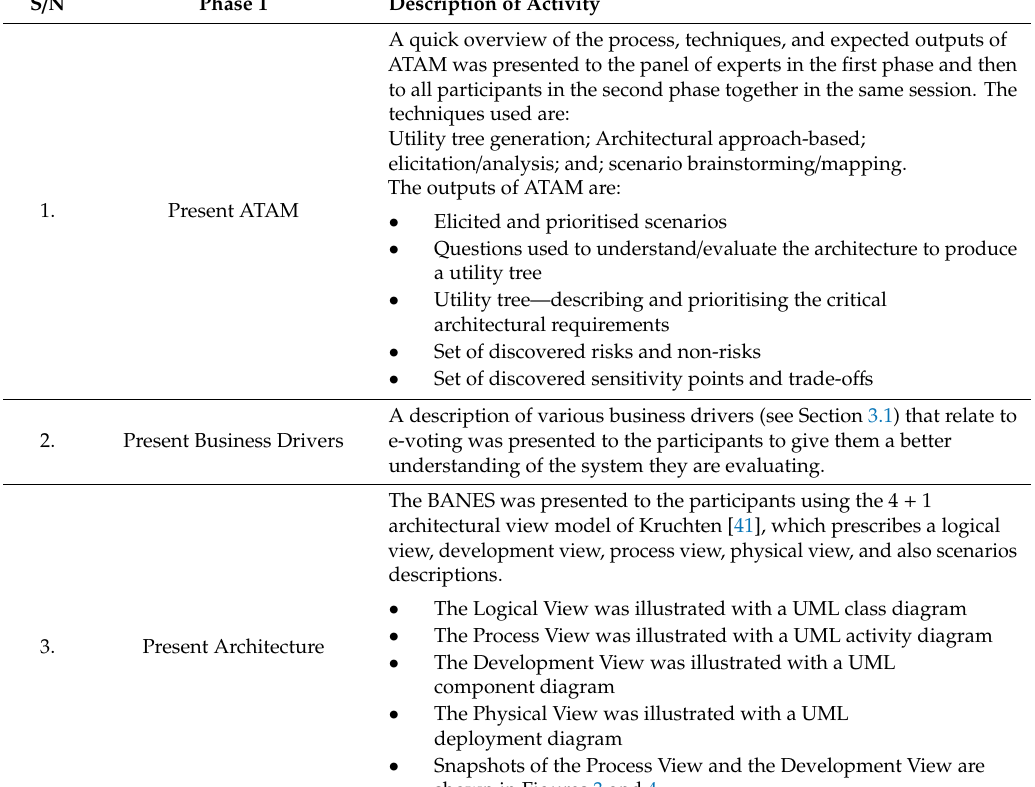
Table 2. Outline of Activities of the ATAM